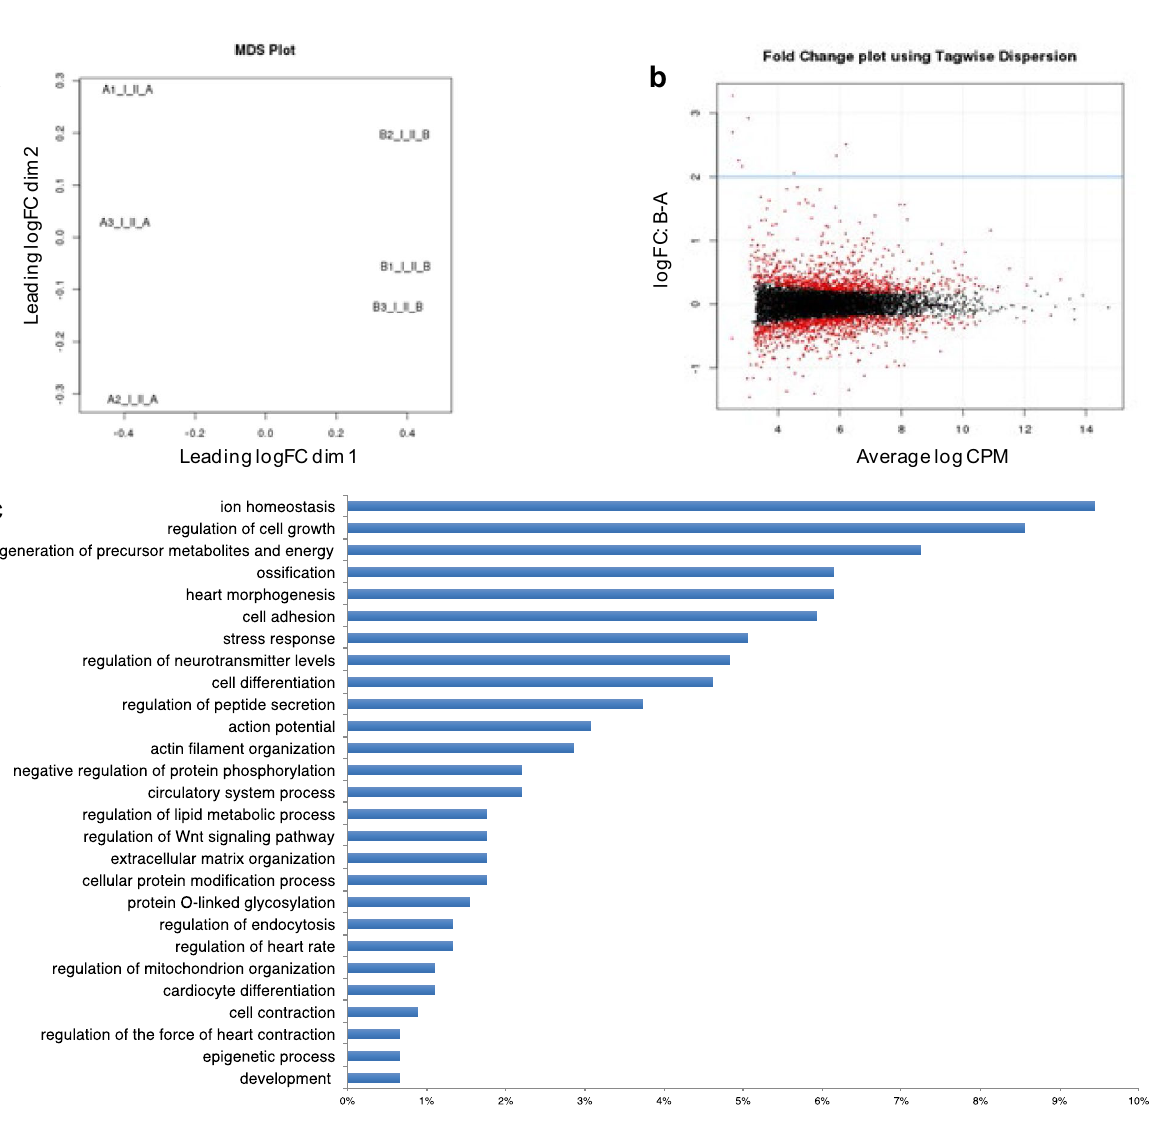
Figure 6. RNAseq analysis identifies T3-induced gene expression modifications in hiPSC-CMs. ( a ) Multidimensional Scaling (MDS) plot showed a clear separation between three replicates of control (A1-A3) and T3-treated (B1-B3) hiPSC-CMs samples. ( b ) Smear Plot of RNA-seq data of different gene expression profile between two groups. Average signal intensity (log CPM versus logFC) of DEGs between ctr and T3 treated iPSC-CMs are shown. The FDR cut-off 0.05 was applied to display the significant DEGs, which are highlighted in red, while non-significant changes are shown in black. Blue horizontal lines represent log2FC. ( c ) GO.BP functional enrichment results bar plot. Length of bar indicates the percentage of genes in each biological